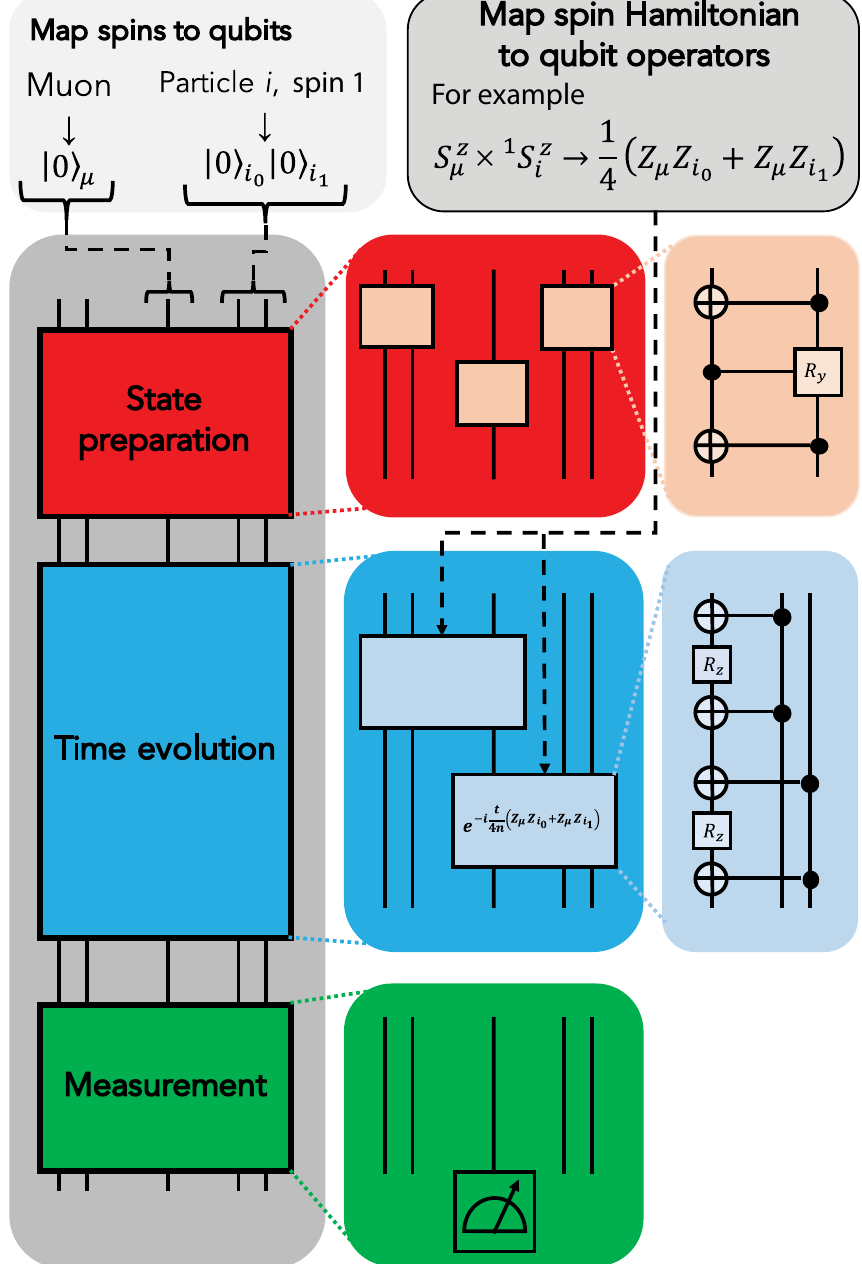
FIG. 2. Outline of the proposed algorithm for simulating muon polarization functions on quantum computers. We first map the spins onto qubits via the mapping in Sec. IV A, which also enables us to map the spin Hamiltonian to qubit operators. We prepare the desired initial state on these qubit registers using the techniques described in Sec. IV B. We can then evolve this state in time, using the methods in Sec. IV C. We can measure the polarization value of the muon qubit, as described in Sec. IV D. This diagram shows the most simple form of the algorithm. This circuit must be repeated many times in order to estimate the Z expectation value of the muon at a single time value. We must repeat this procedure for each desired time value. This will generate a simulated polarization function, which can be incorporated into, for example, an optimization routine to determine the muon rest site, by fitting the generated data to experimental